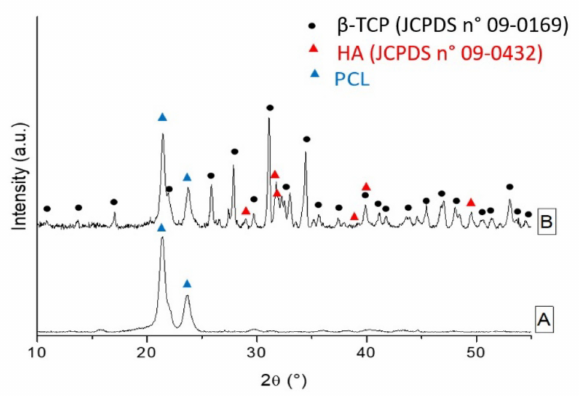
Figure 2. X-ray Diffraction (XRD) patterns of a neat PCL scaffold ( A ) and of the BCP/PCL composite scaffold ( B